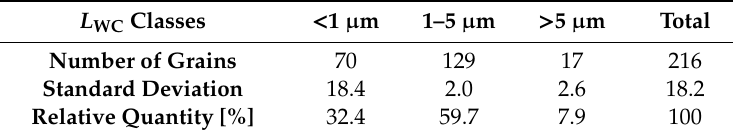
Table 3. Results of the L WC evaluation by intercept